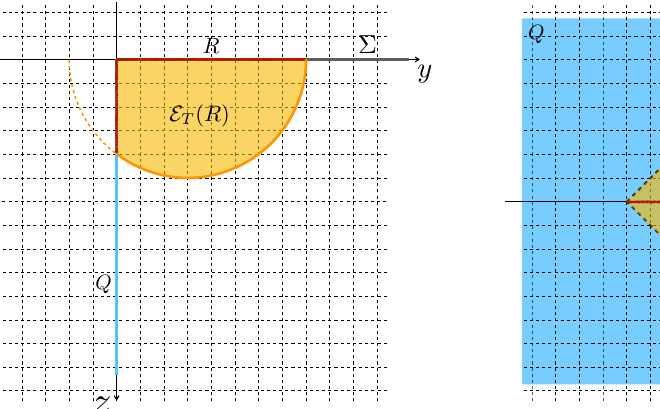
Figure 13 . A simple example showing the breakdown of C ⊆ E T . Consider a d = 2 vacuum setup with a vanishing tension T = 0 . The left figure shows the t = 0 slice, and the right figure shows Σ ∪ Q . In this case, Q is perpendicular to Σ , and z -coordinate coincides the minus direction of y - coordinate. Taking subregion R (red) as − 4 ≤ y ≤ 8 and t = 0 . The tentative entanglement wedge E T ( R ) is shown in yellow. The geometrical domain of dependence D int by the bold dotted lines in the right picture and goes outside of E also goes outside of E ( R ) T